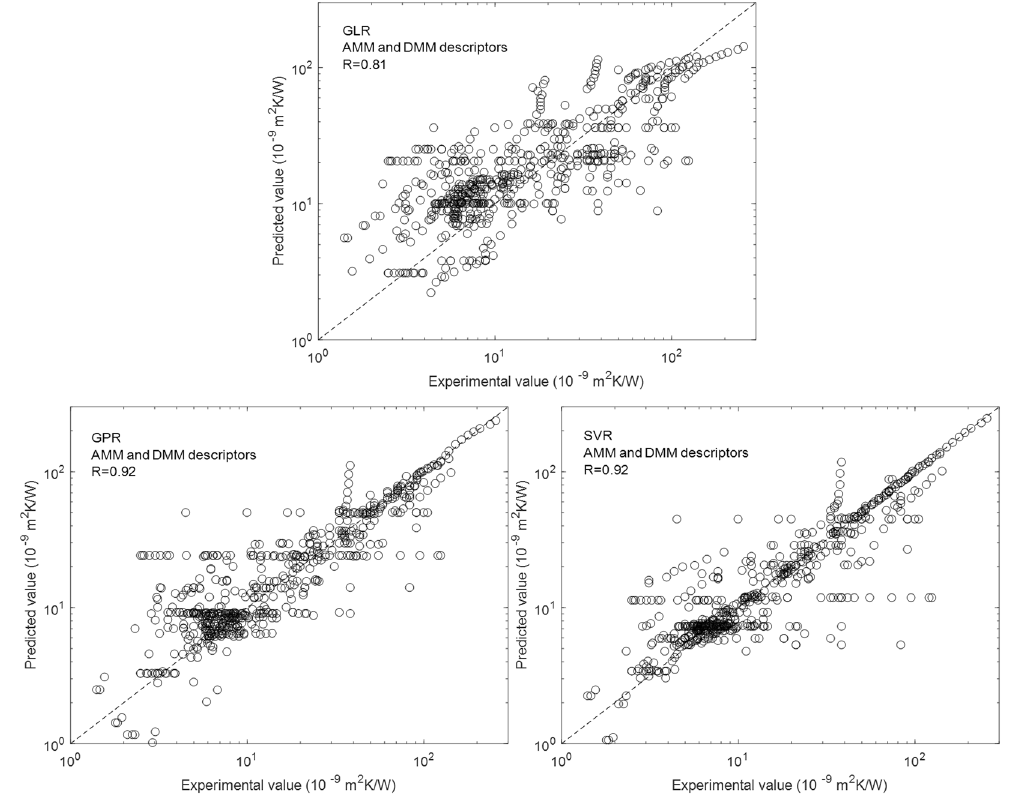
Figure 2. Correlation between the experimental values and the values predicted by the GLR, GPR, and SVR models using the AMM and DMM descriptors.